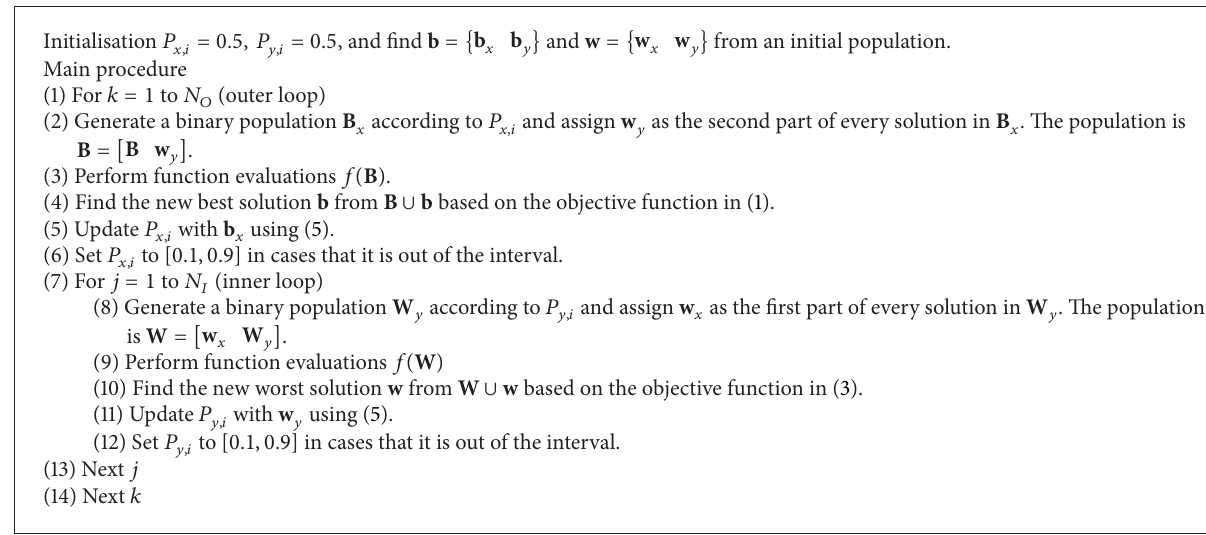
Algorithm 2: Population-based incremental learning for